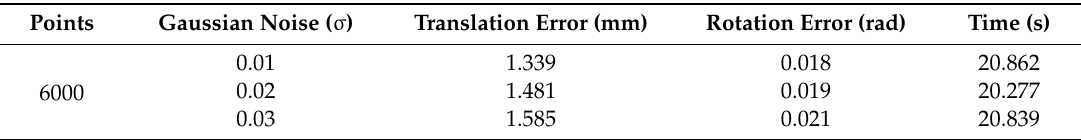
Table 5. Experimental results using the connector model obtained by the proposed coarse registration method with different levels of Gaussian